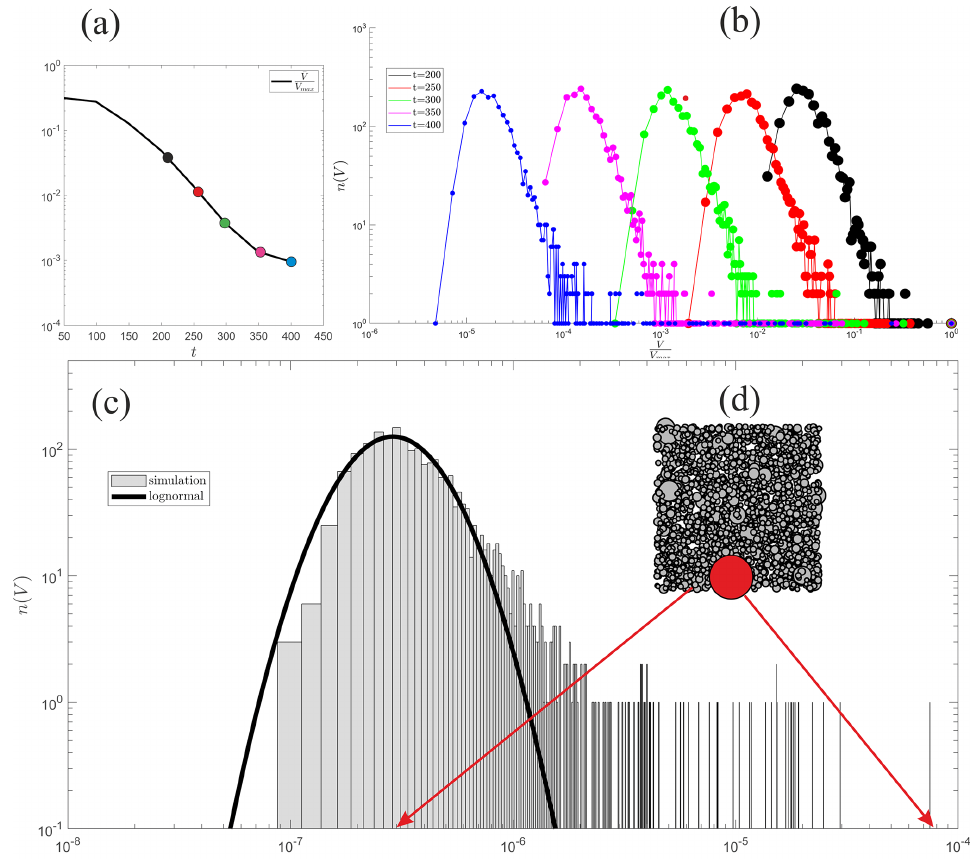
Figure 6. Simulation of a finite sample with N = 2000 particles. Inset (a) shows the evolution of the mean volume normalized by the maximal volume. Inset (b) depicts the evolution of the distribution; the corresponding points in (a) are denoted by the same color. The green curve ( t = 300) is the one shown in detail in panel (c) ; it depicts the particle volume histogram after 300 collisions per particle. The gray boxes show the logarithmically binned histogram; the black line is a lognormal fit to the data. Observe the existence of outliers on the right. Inset (d) is a visual illustration of the entire population: all particles are placed randomly into a 2D container. Smaller particles were placed first and the white content (gray scale) is proportional to the linear size of the particle. One small particle close to the mean and one large particle (outlier) are marked with red and their position is indicated in the